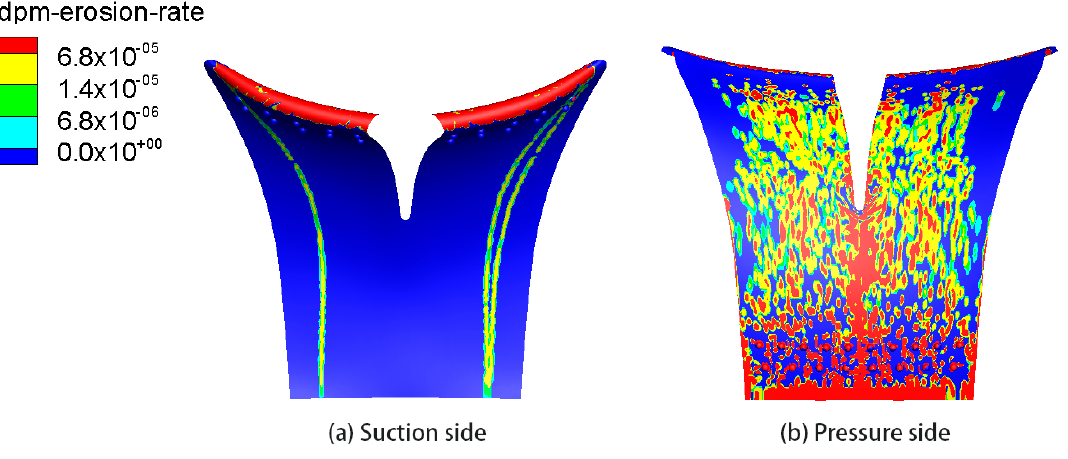
µ m/s, particle size: 0.4725 Figure 19. Silt erosion on blade surface with bionic convex domes (units: μ m/s, particle size: 0.4725 mm). Figure 19. Silt erosion on blade surface with bionic convex domes (units: Figure 19. Silt erosion on blade surface with bionic convex domes (units: μ m/s, particle size: 0.4725 mm). Figure 19. Silt erosion on blade surface with bionic convex domes (units: μ m/s, particle size: 0.4725 mm).